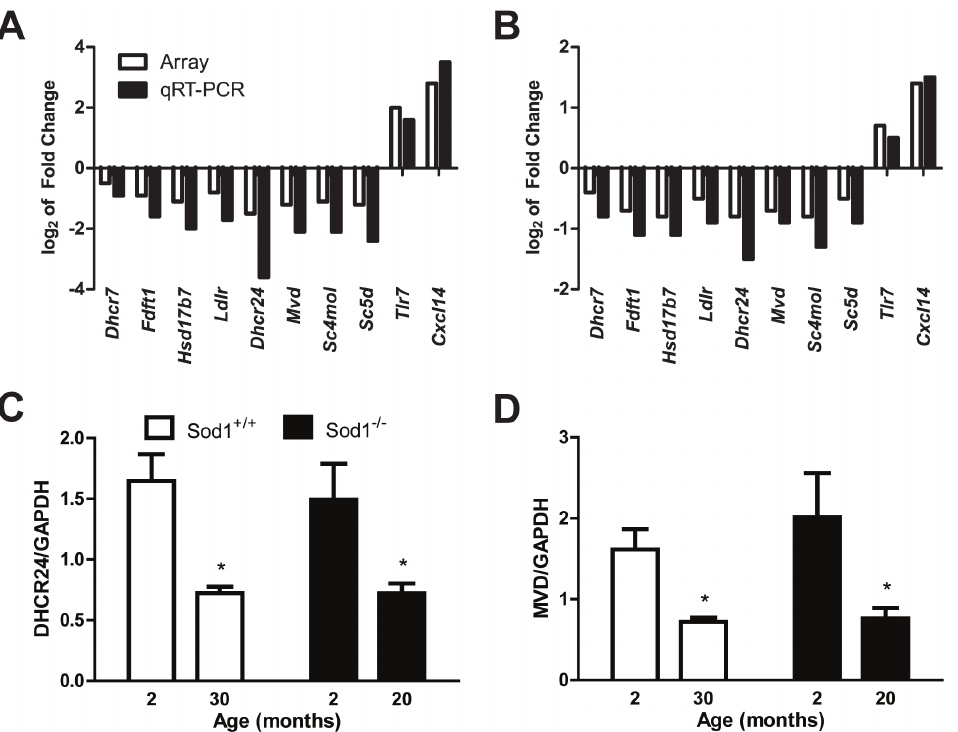
Figure 5. qRT-PCR verification of the expression levels of the DEGs in the sciatic nerve. The log 2 transformation of the fold-change of the relative mRNA expression levels in the 10 DEGs selected for qRT-PCR (black bars) parallels the direction of changes in the microarray (white bars) in A) normally aged mice, the Sod1 + / + mice at 20 mo compared with 2 mo mice, and B) in a model of increased oxidative stress, the Sod1 2 / 2 mice at 30 mo compared with 2 mo mice. Western immunoblotting densitometry was used to validate the protein expression levels of two genes that were differentially expressed and encode enzymes in the cholesterol/sterol synthesis pathway, C) DHCR24 and D) MVD; *p , 0.05 and **p , 0.01.